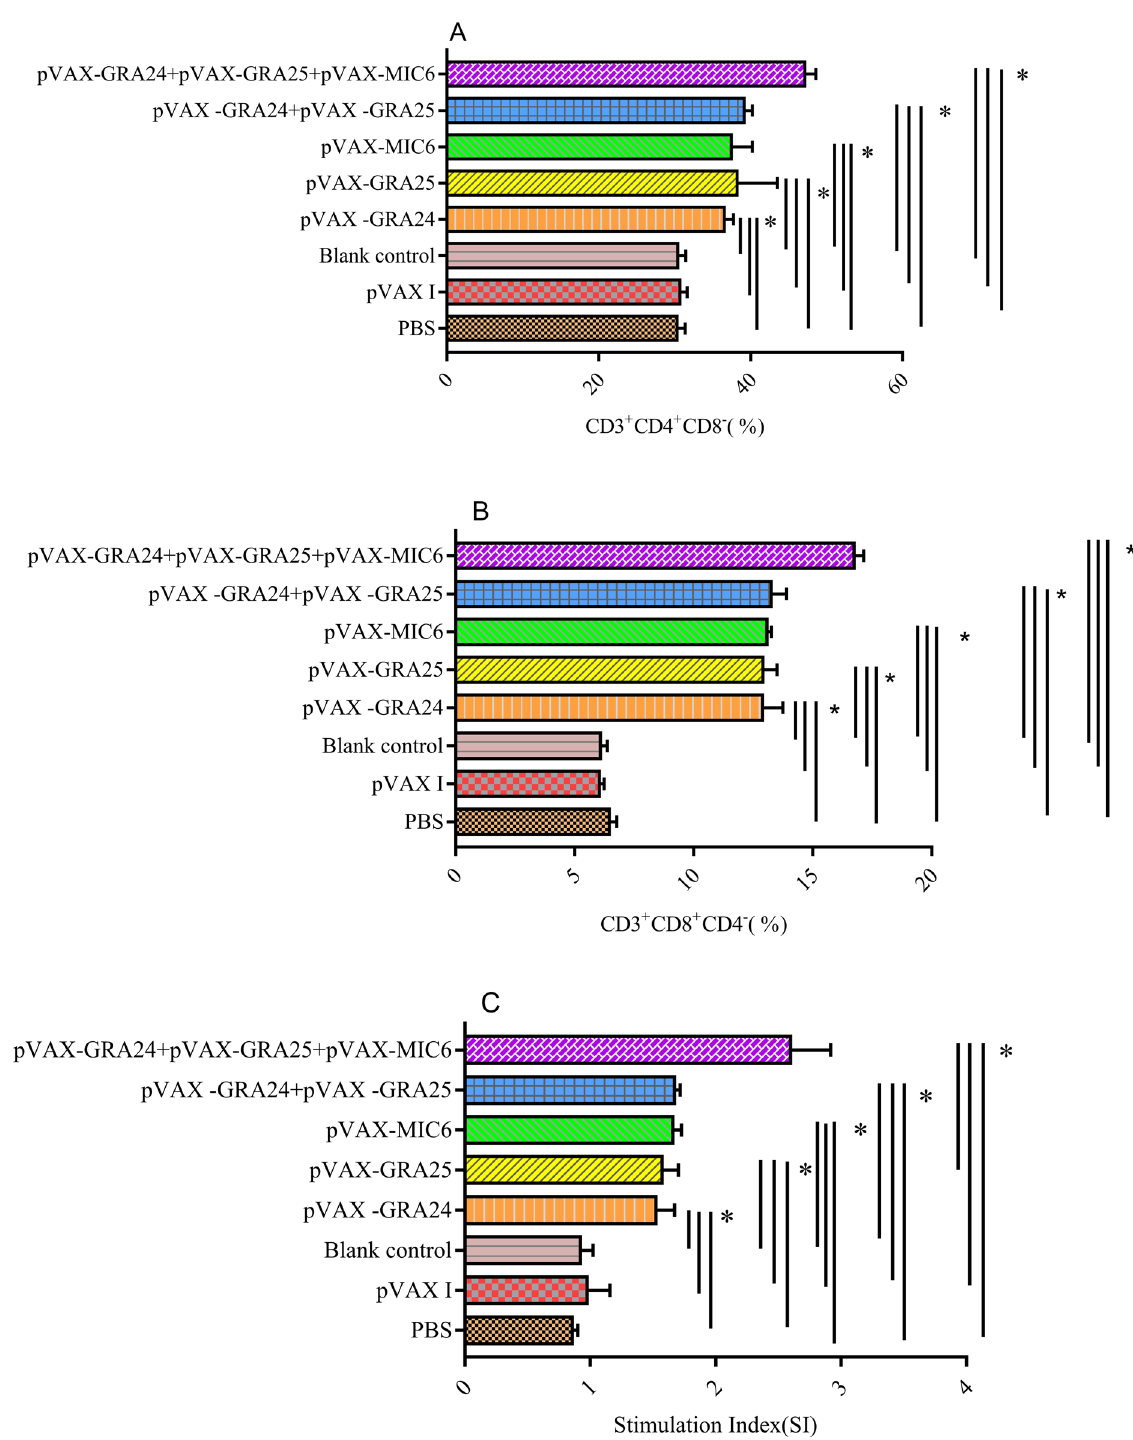
Figure 4. Splenocyte proliferation and the percentages of CD4 + and CD8 + of T cells in immunized and control mice. Determination of the percentages of CD4 + or CD8 + T cells in immunized and control mice (A, B). Lymphocyte proliferation stimulation index (SI) (C). * p <